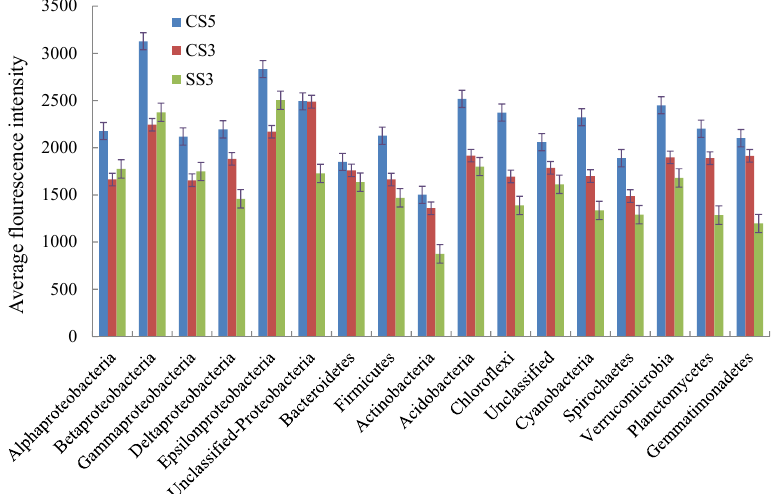
Membranes 2023 , 13 , x FOR PEER REVIEW Figure 5. Average PhyloChip hybridization signal intensities for the three MBRs at the phylum level.